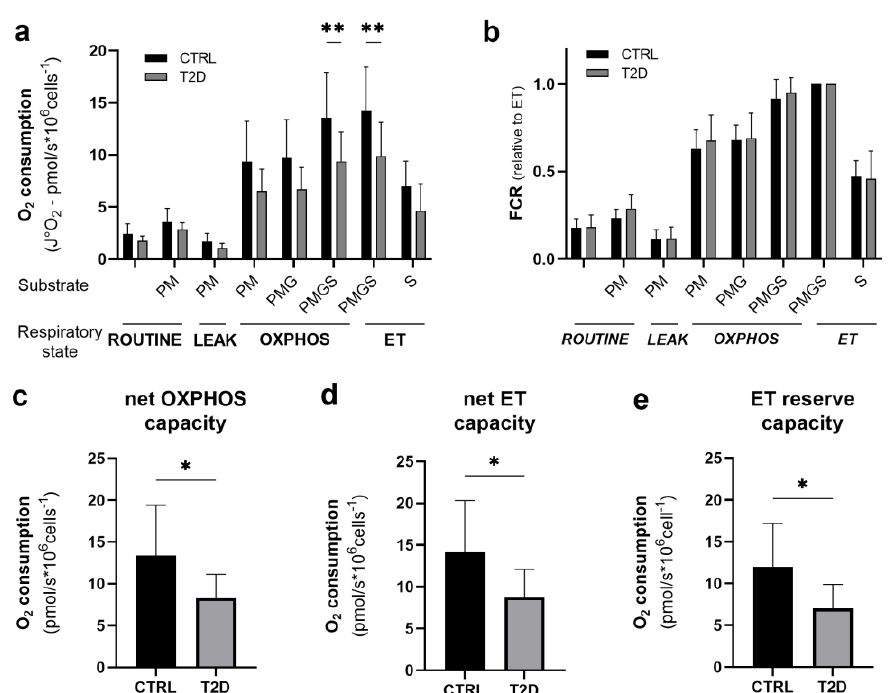
Figure 2. Analysis of mitochondrial function in PBMCs from CTRL and T2D samples. ( a ) Quantitative analysis of the rate of oxygen consumption (expressed as O 2 pmol/s per million cells) in the ROUTINE, LEAK, OXPHOS and ET respiratory states in PBMCs from CTRL and T2D blood samples. ( b ) Qualitative analysis of data of mitochondrial function in permeabilized PBMCs expressed relative to ET (flux control ratio, FCR) in the respiratory states analyzed ( ROUTINE , LEAK, OXPHOS and ET ). ( c ) Net OXPHOS capacity, index of ADP stimulation, for CTRL and T2D PBMC cells calculated as (OXPHOS – LEAK). ( d ) Net ET capacity for CTRL and T2D PBMC cells calculated as (ET – ROUTINE). Data are reported as mean ±